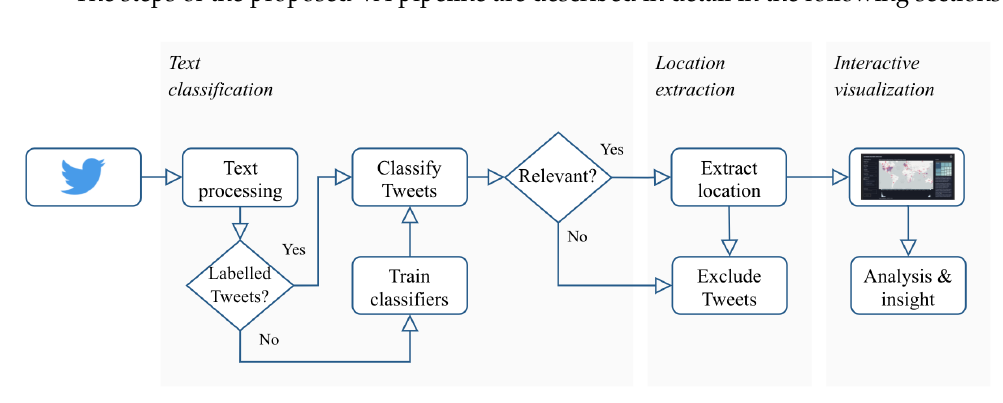
Figure 1. Proposed VA pipeline with the steps: (1) text classification, (2) location extraction, and (3) interactive